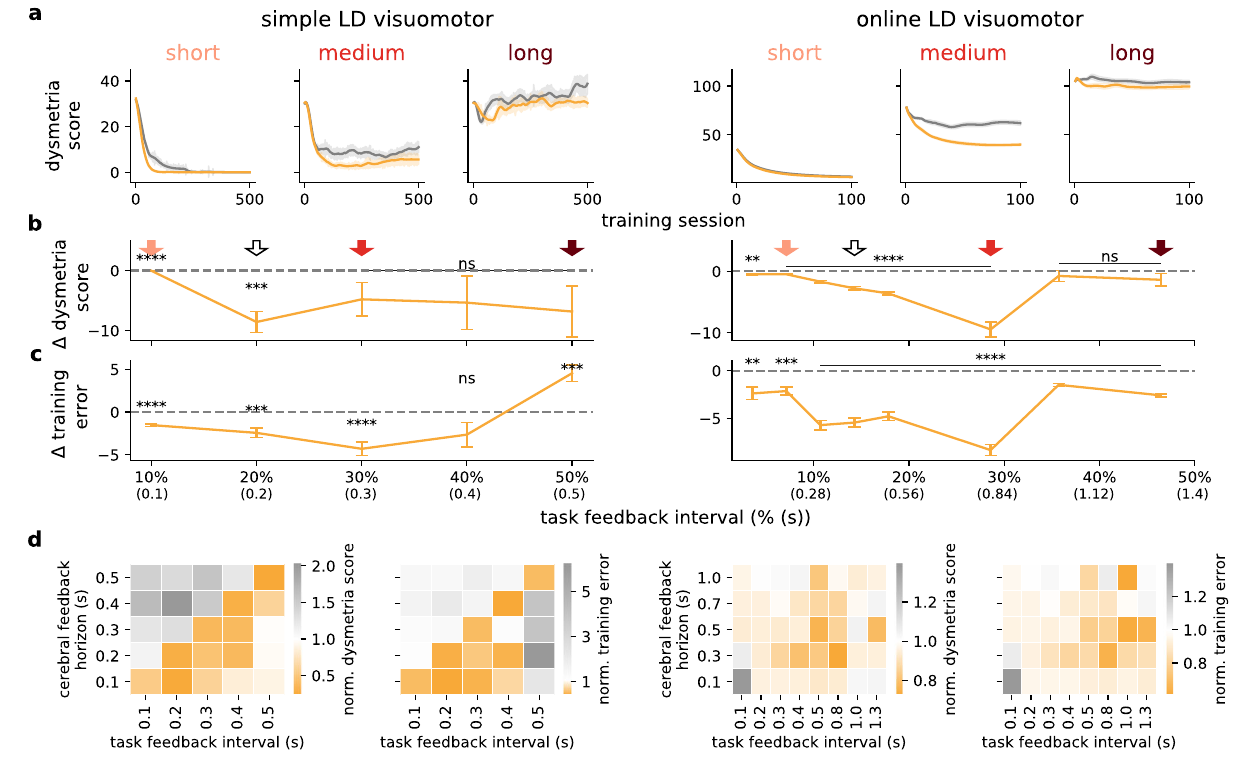
Fig. 4 | Cerebellar-mediated facilitation of learning depends on task feedback interval.a Dysmetriascoreduring learningfor short(light red), medium (red)and long(darkred)levelsof feedbackintervalforthesimpleandonlineLD visuomotor tasks and both models cRNN (gray) and ccRNN (orange). Degrees of redness b Difference in dysmetria score between ccRNN and cRNN for varying degrees of taskfeedbackintervals(nsdenotesnotsigni fi cant: p =0.122(30%), p =0.268(40%), p =0.142 (50%) for simple LD and p =0.444 (36%), p =0.209 (46%) for online LD). Degrees of red in arrows indicate the respective interval as in ( a ) while the white arrowindicatesthefeedbackintervalusedinFigs.2and3.Taskfeedbackintervalis